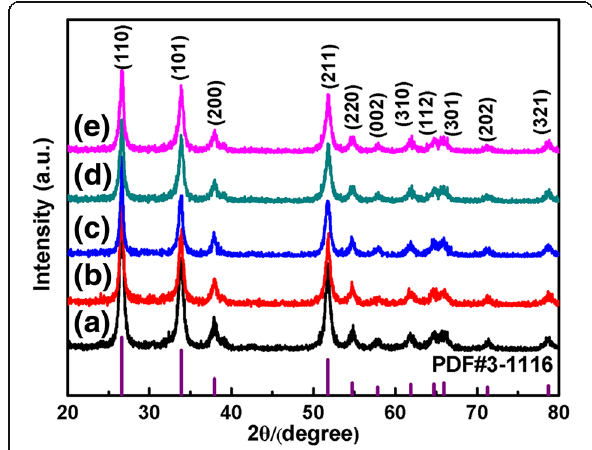
Fig. 3 XRD patterns of the SnO 2 samples with different morphologies. a S 0 , b S TritonX100 , c S HMT , d S PEI , and e S PVP